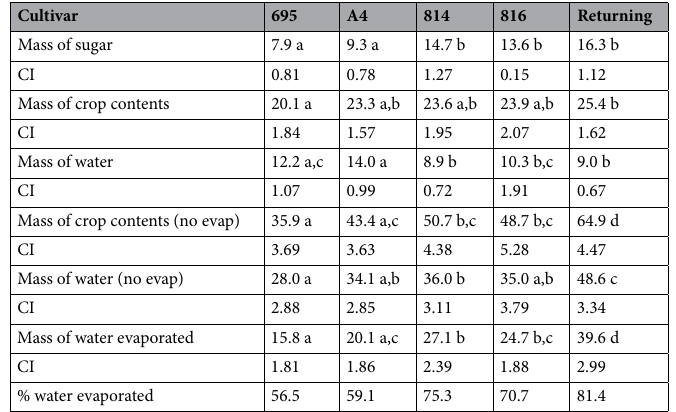
Table 1. Mass of sugar, water and crop contents in honey bee crops with and without evaporation. Values in mg (mean and 95% confidence interval, n = 30). Different letters within a row indicate significant differences.